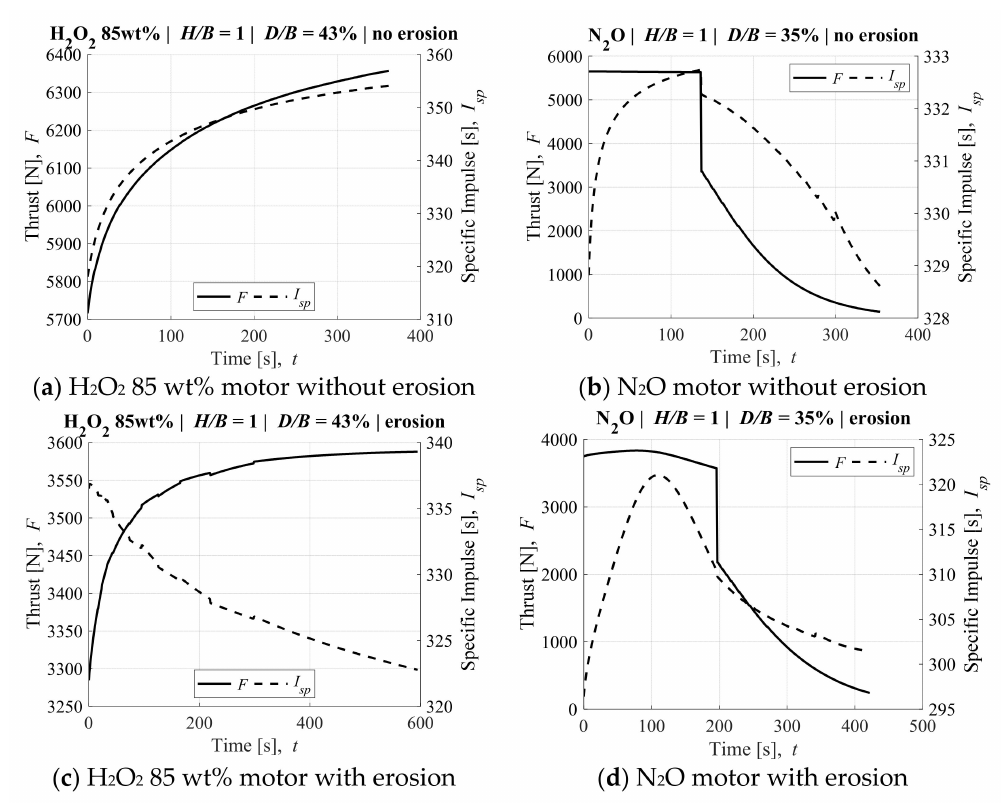
Figure 19. Comparison of thrust and specific impulse